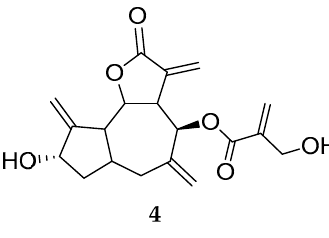
Figure 5. Structure of cynaropicrin ( 4 ).